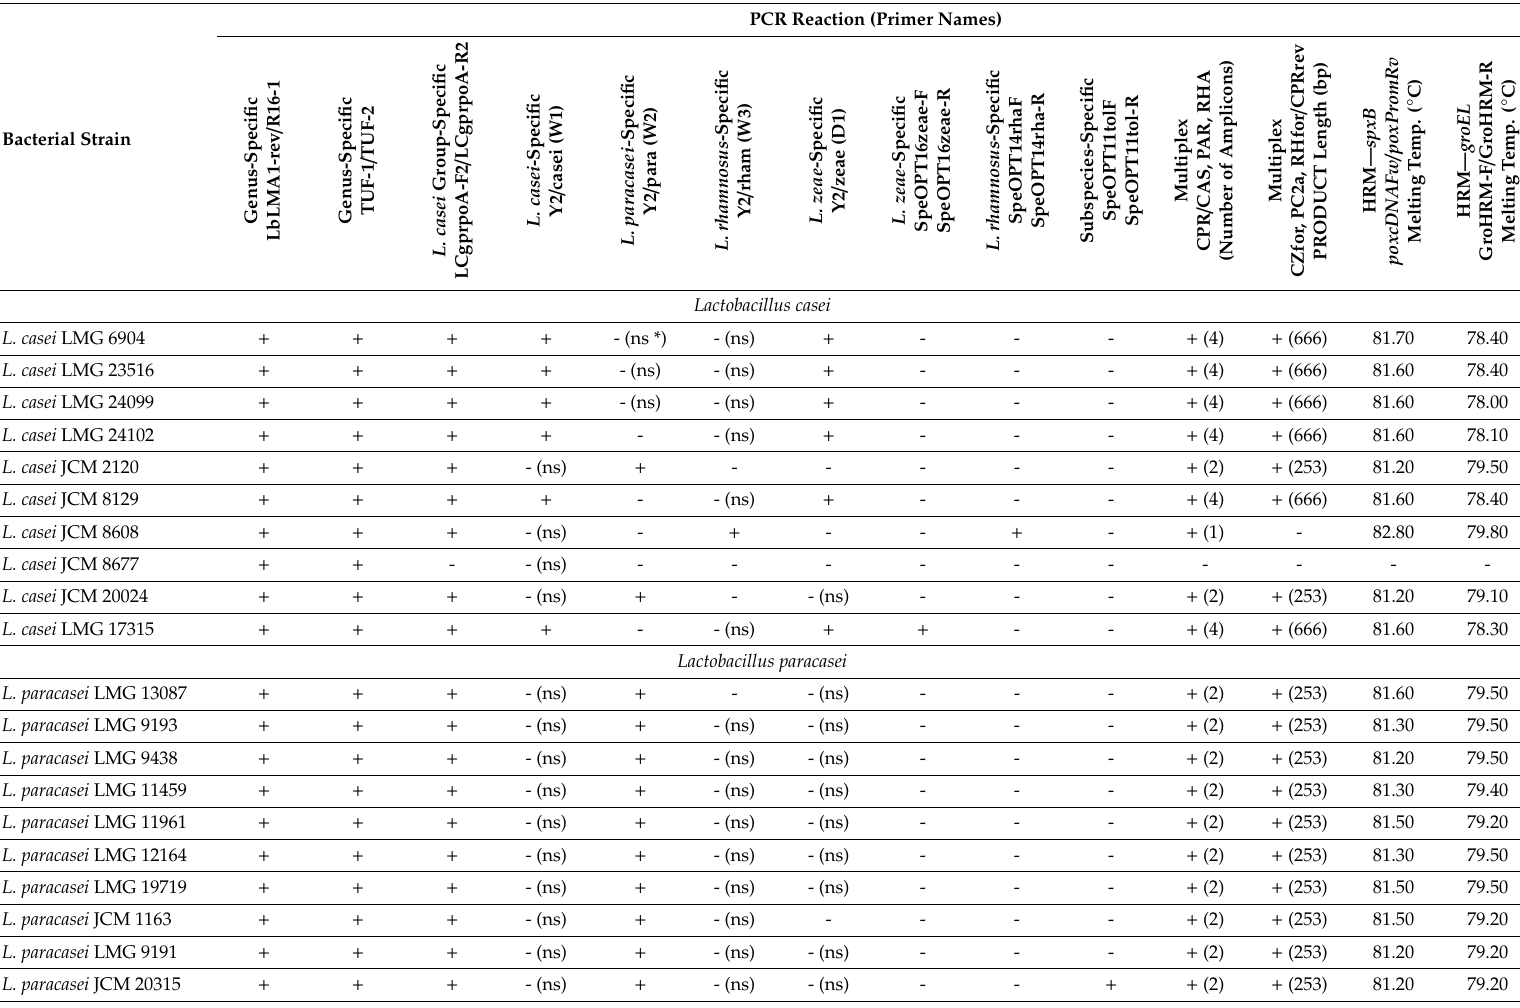
Table 1. Results obtained in various PCR reactions using 30 bacterial strains of L. casei group. Detailed information on the PCR reaction conditions and primer sequences is provided in Table